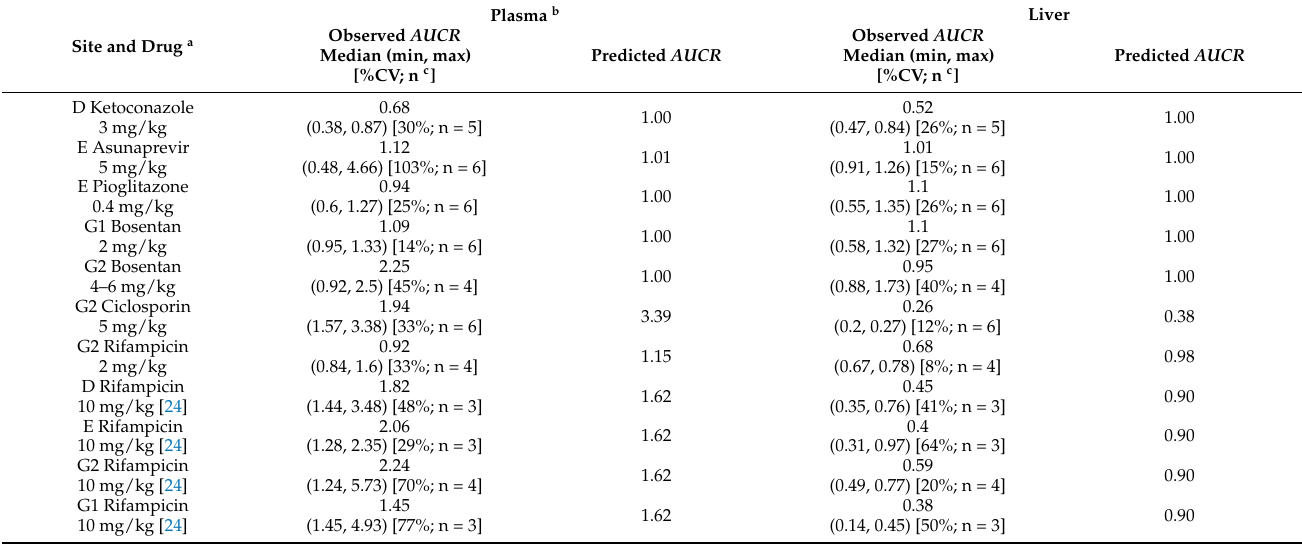
Table 4. Observed and physiologically-based pharmacokinetic model (PBPK) based prediction of the ratio of gadoxetate area under the curve, based on ∆ R 1 , in the presence of investigated drugs relative to the vehicle control (AUCR), in plasma and liver.